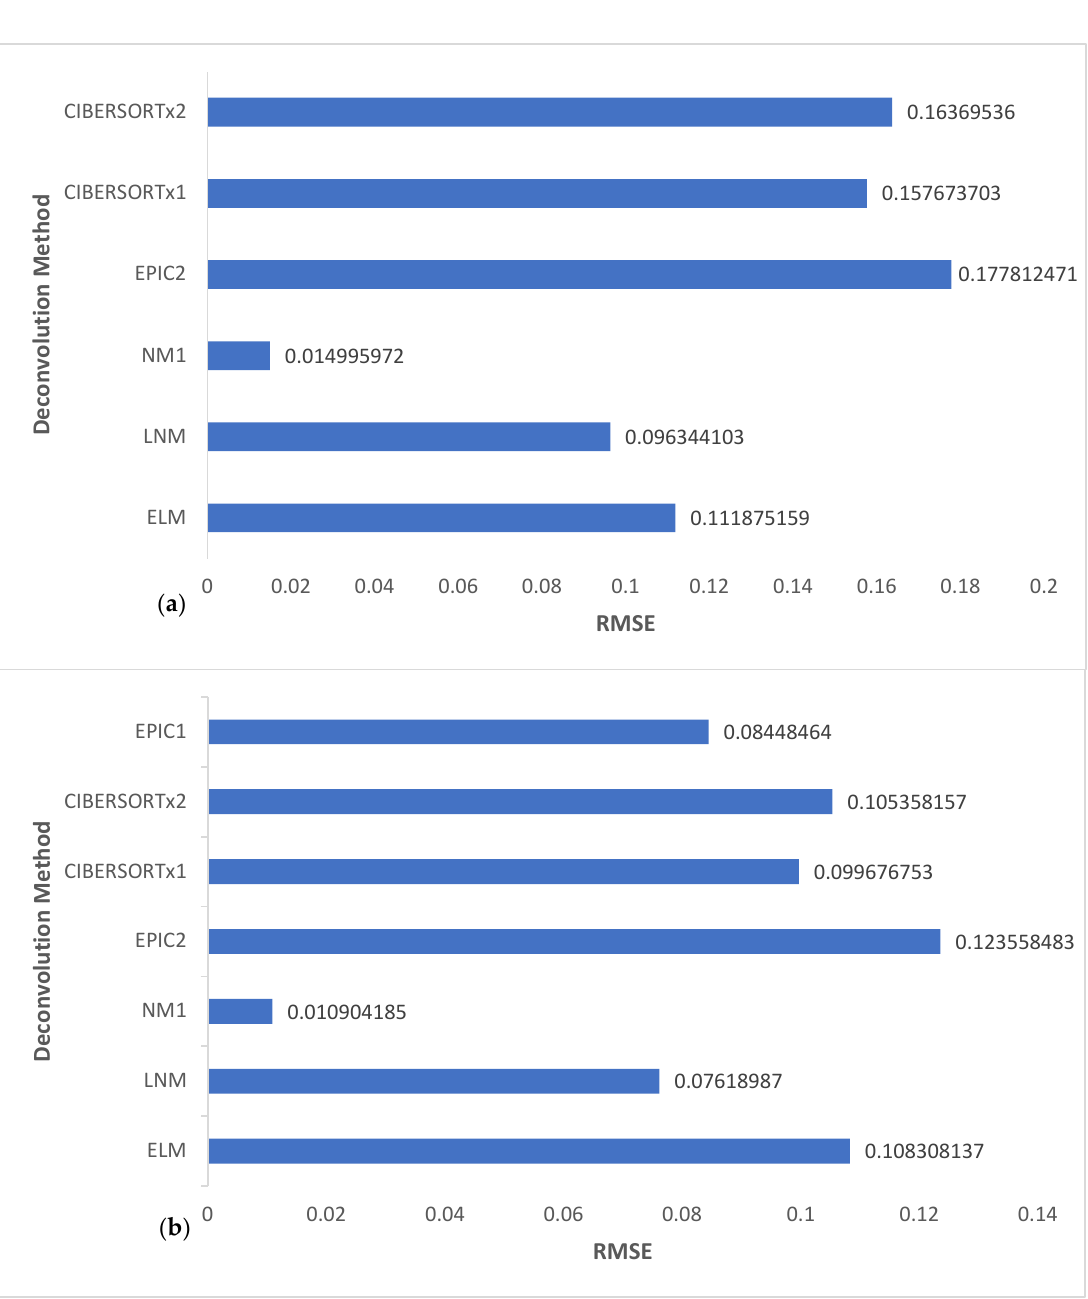
Figure 3. Comparison of the RMSE values of versions of the nonlinear framework, EPIC, and CIBERSORTx for ( a ) 24 observations including six cell subsets of the four melanoma samples, and ( b ) 16 observations including only the four TIICs of the four melanoma samples.